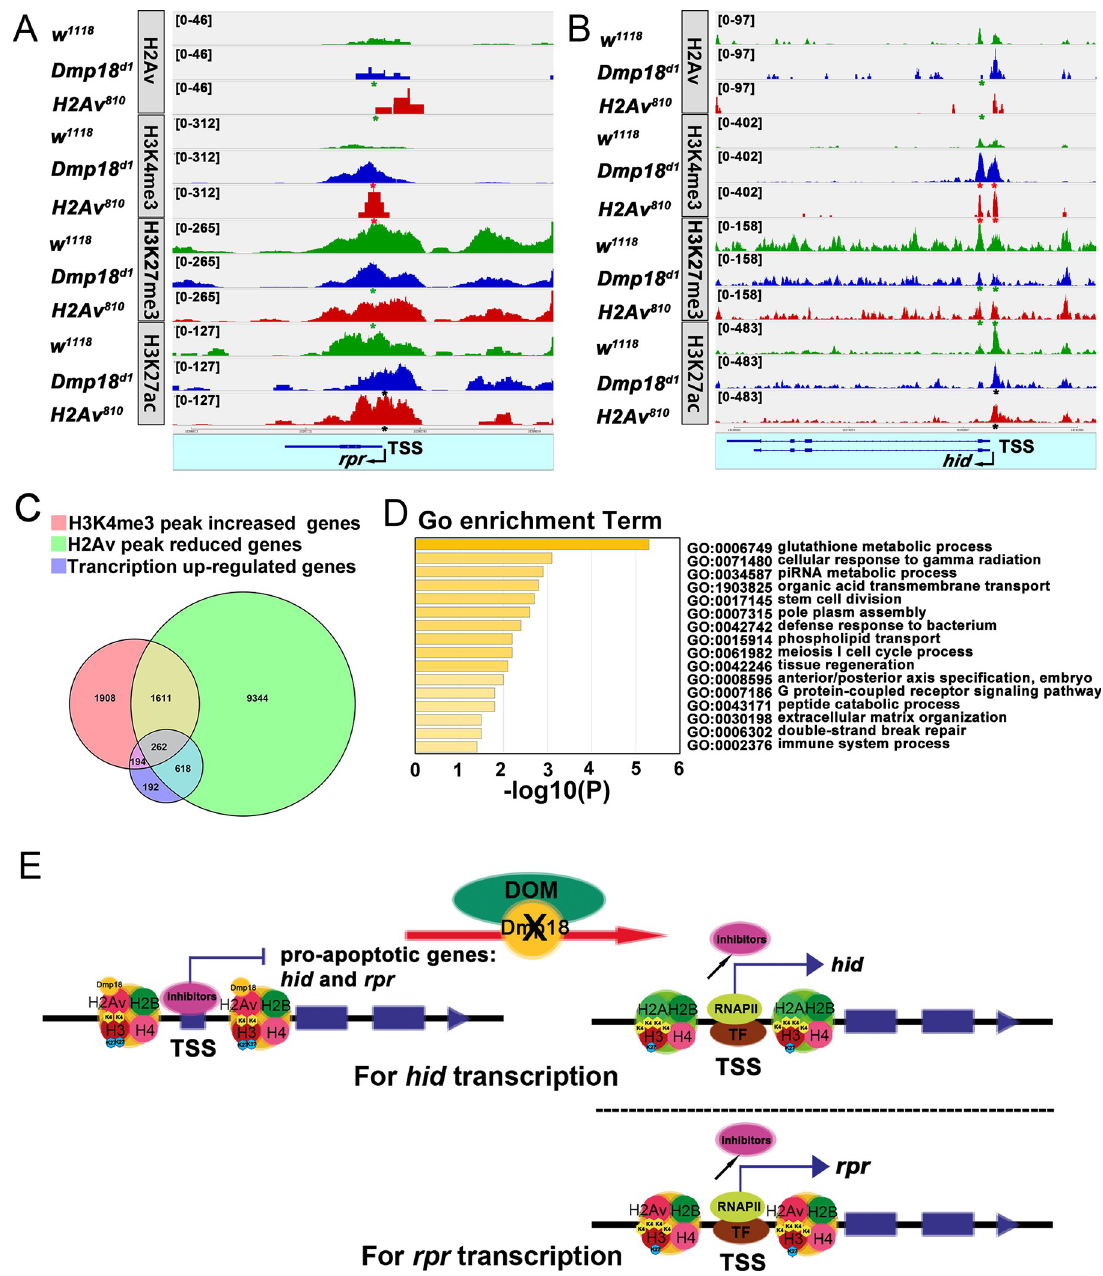
Fig 8. Dmp18 mediates H2Av incorporation and histone H3 modifications at the TSS regions of pro-apoptotic genes for transcriptional regulation. (A and B) The CUT&Tag assay and sequencing were performed to examine the binding of H2Av (row 1 to 3), H3K4me3 (row 4 to 6), H3K27me3 (row 7 to 9), and H3K27ac (row 10 to 12) at the TSS regions of rpr and hid in w 1118 , homozygous Dmp18 d1 and homozygous H2Av 810 . The binding of H2Av at the TSS region of rpr (A) was not changed, but its binding at hid (B) was reduced in Dmp18 d1 and H2Av 810 (green asterisks marked). The binding of H3K4me3 at the TSS regions of hid and rpr was increased in Dmp18 d1 and H2Av 810 (red asterisks marked). The binding of H3K27me3 at the TSS regions of hid and rpr was slightly reduced in Dmp18 d1 and H2Av 810 (green asterisks marked). The binding of H3K27ac at the TSS regions of rpr and hid was not obviously changed (black asterisks marked). (C) Venn diagram showed the overlap of H2Av-binding reduced genes, H3K4me3-binding increased genes, and Dmp18 up-regulated genes. (D) GO analysis of the overlapped genes in C. (E) The working model of Dmp18 regulating apoptosis in Drosophila : Dmp18 regulates apoptosis by mediating H2Av incorporation and histone H3 modifications at the TSS regions of pro- apoptotic genes for transcriptional regulation. For hid transcription, Dmp18 mediates the H2Av incorporation and both H3K4me3 and H3K27me3 modifications for transcriptional regulation. For rpr transcription, Dmp18 directly or indirectly mediates H3K3me4 and H3K27me3 modifications for transcriptional regulation.